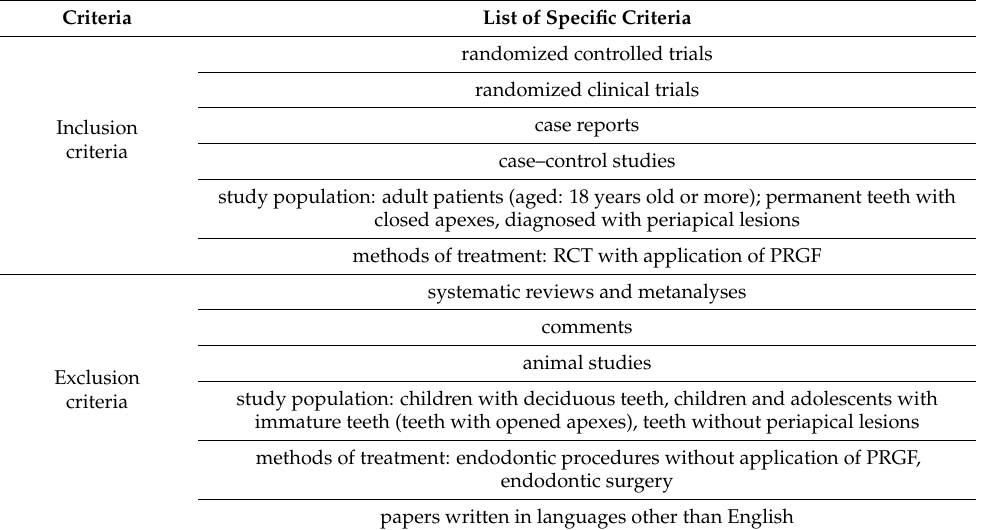
Table 4. Inclusion and exclusion criteria for the narrative